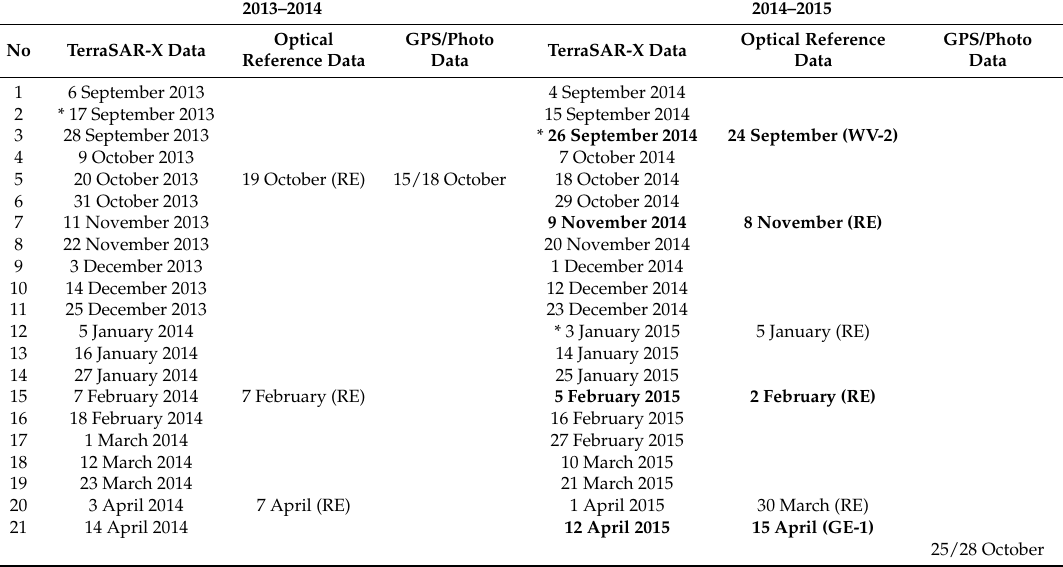
Table 2. Remote sensing data used in this study. Main dataset: TerraSAR-X dual-co-polarimetric HH-VV StripMap time series. Reference datasets: RapidEye (RE), WorldView-2 (WV-2), GeoEye-1 (GE-1), and GPS/photo data. Data marked in bold were used as reference datasets for the areas of interest